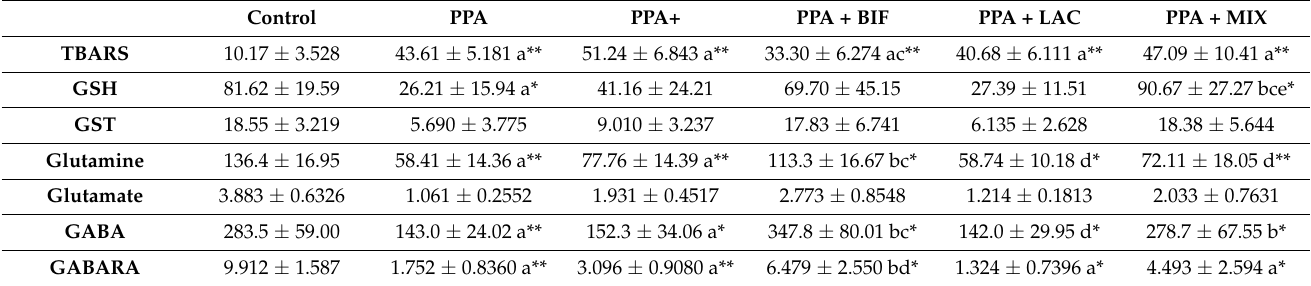
Table 1. Means ± SD of all the measured variables in the brain homogenates of the six studied groups. Control